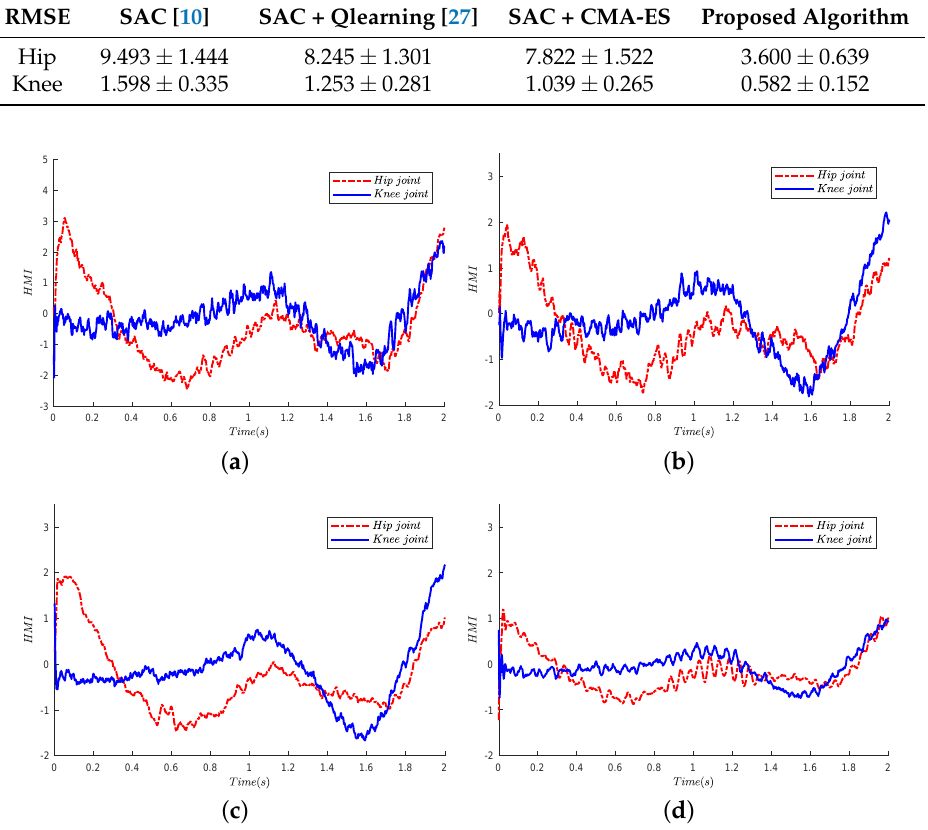
Table 1. Average performance of HRI (RMSE).